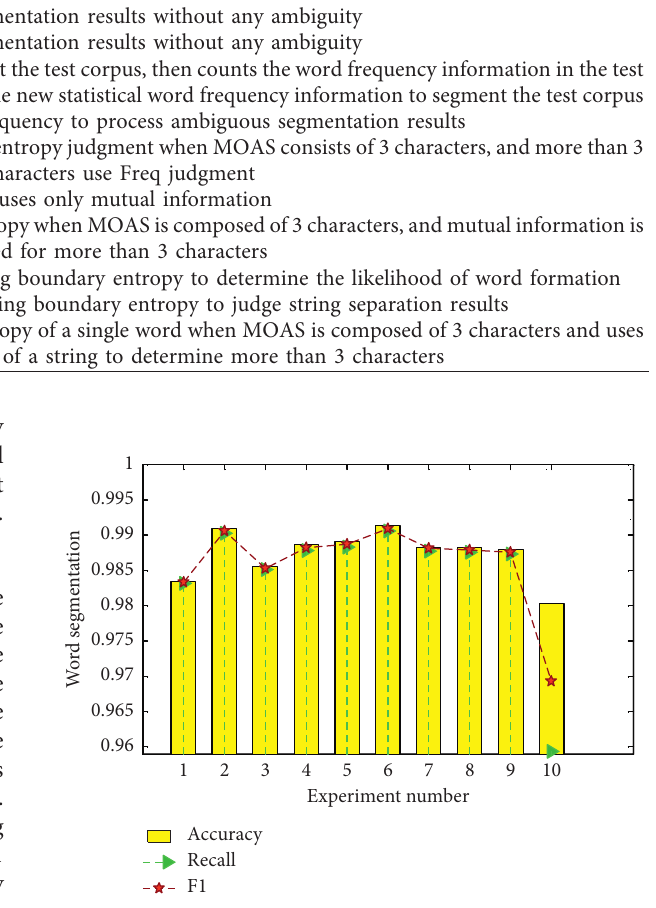
Figure 6: Various word segmentation results of Fish without OOV.